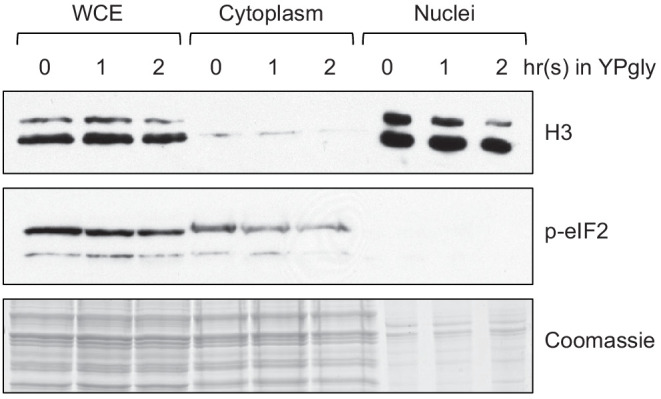
Confirmation of efficient yeast subcellular fractionation of the samples shown in Figure 3D.One percent of whole-cell extract (WCE), 1% of cytoplasm, and 2% of nuclei samples used in Figure 3D were subjected to western blots to confirm efficient subcellular fractionation. Histone H3 and phosphorylated eIF2 (p-eIF2) antibodies were used as the nuclear and cytoplasmic markers, respectively.